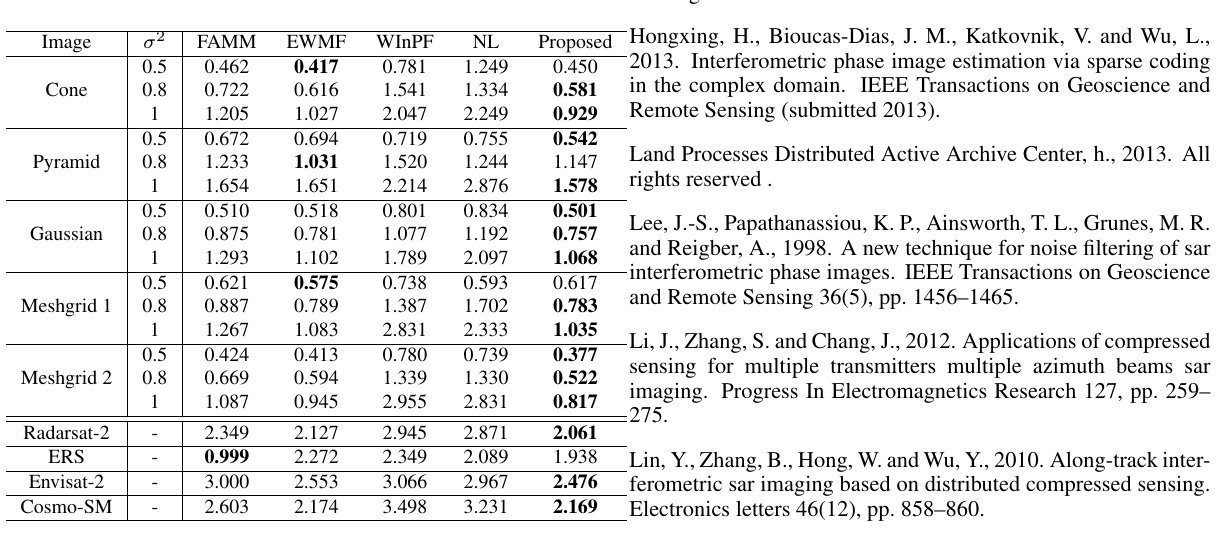
Table 1: Mean Square Error (MSE) computed using different fil- tering algorithms. The first part of table: MSE of simulated inter- ferograms with different noise variances. The second part: MSE between interferograms obtained using ASTER’s DEM and the filtered